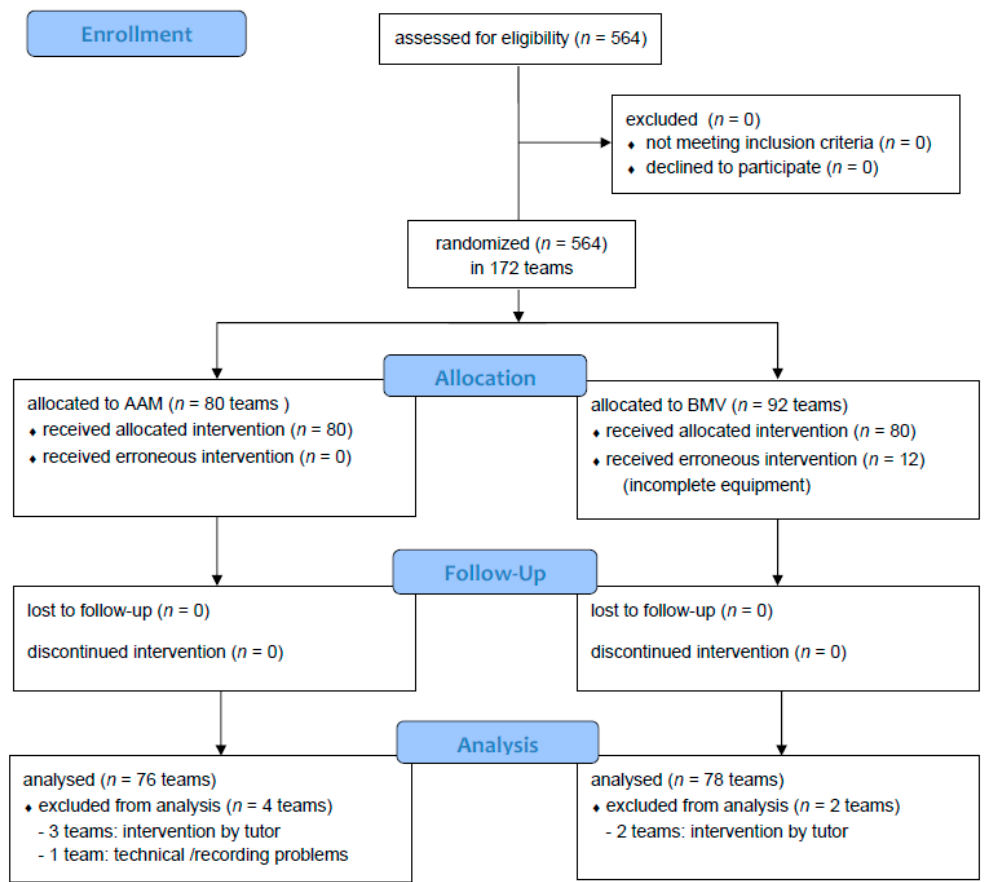
Figure 1. CONSORT Flow Diagram of the trial. BMV = bag-mask ventilation; AAM = advanced airway management.